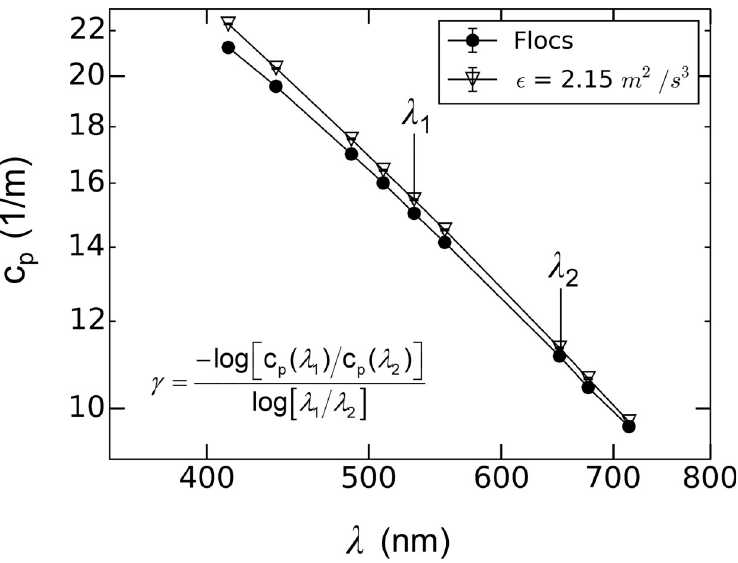
Fig 6. Plot of in-water light attenuation measured with the ac-9 spectrophotometer as a function of wavelength.